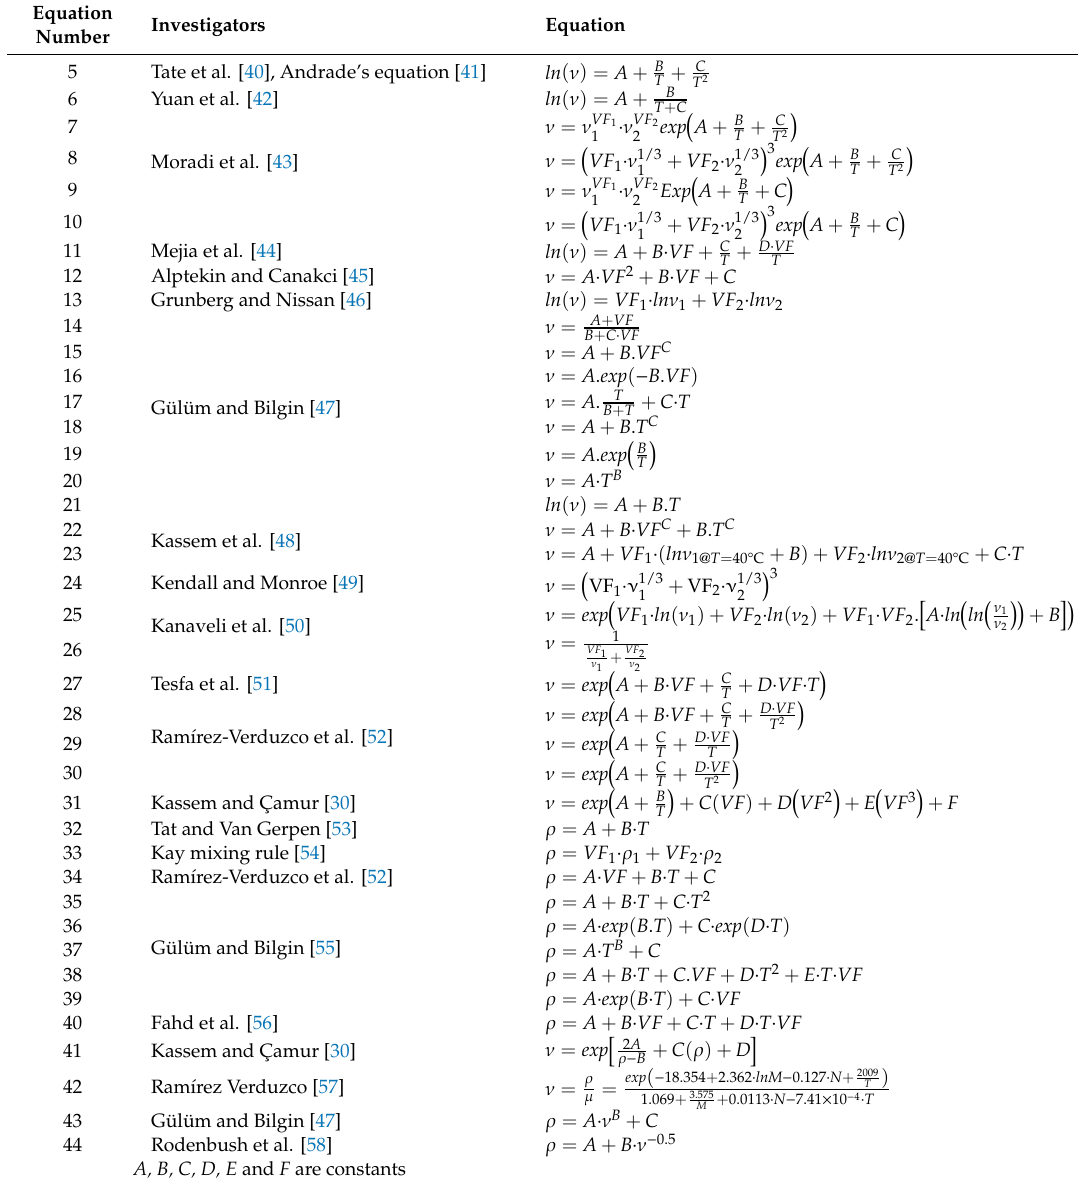
Table 3. Proposed correlations by scientific